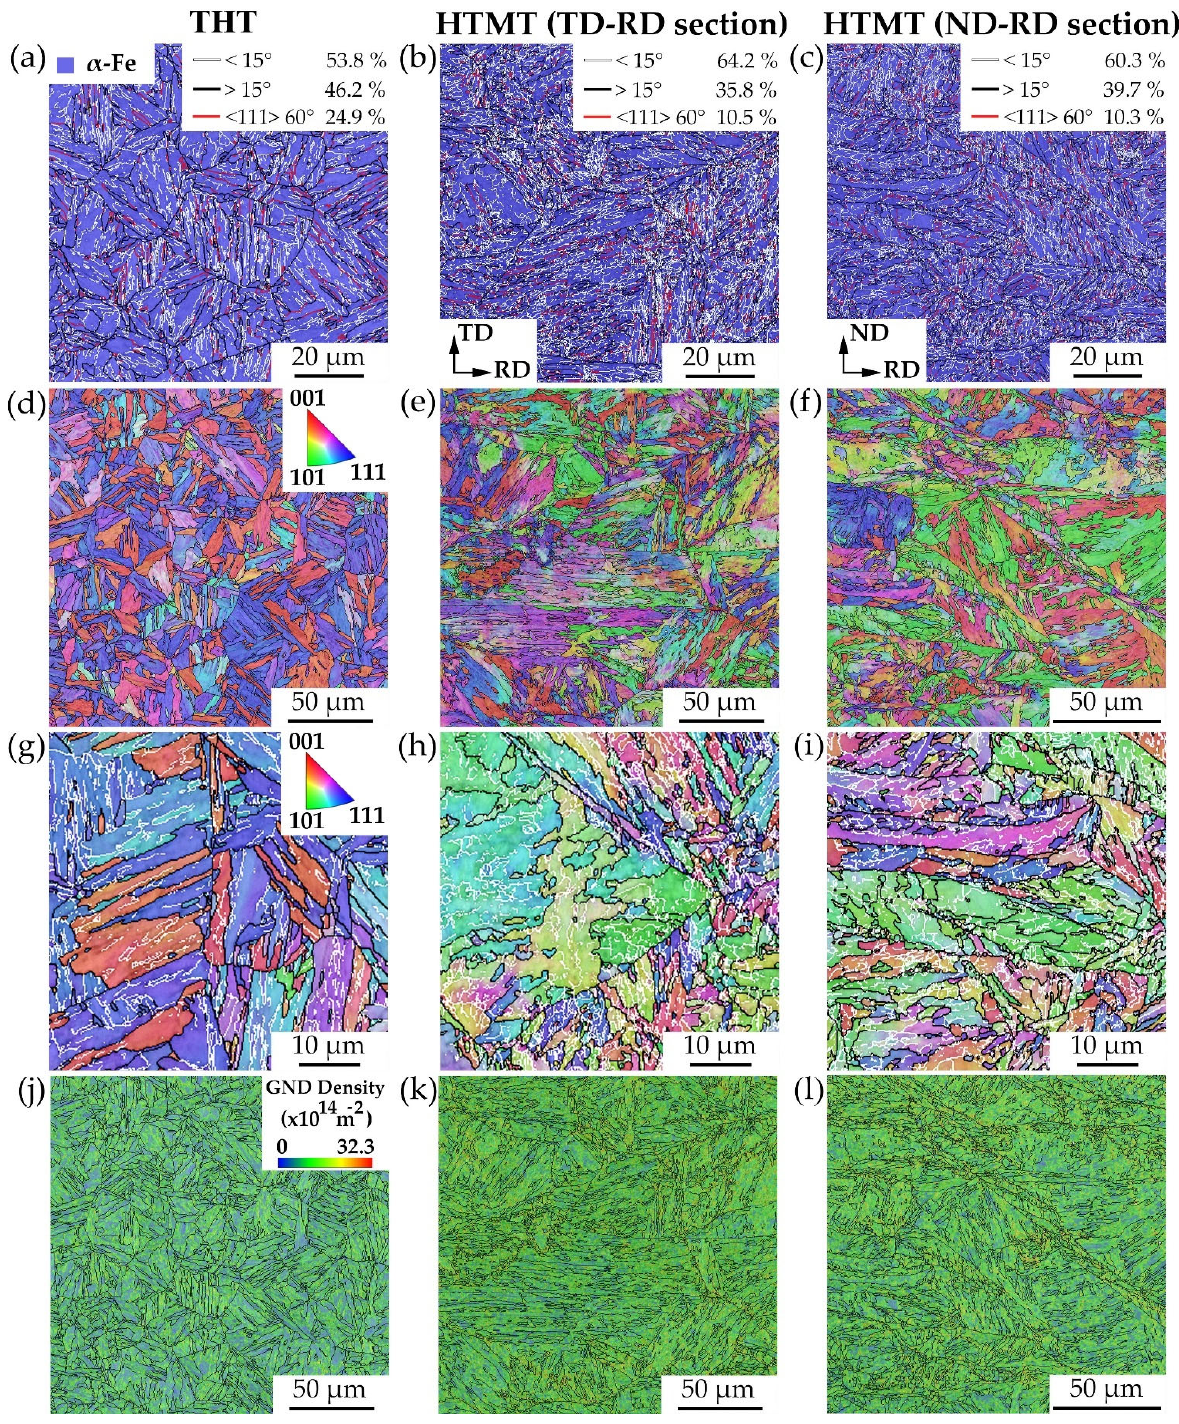
Figure 6. SEM EBSD images of steel microstructure after THT ( a , d , g , j ), HTMT in the section, parallel to the rolling plane ( b , e , h , k ), and in the cross section ( c , f , i , l ). Phase maps ( a – c ), where BCC-Fe is in blue color. IPF (Inverse Pole Figures) orientation maps ( d–i ), corresponding GND (Geometrically Necessary Dislocations) maps ( j – l ). High ‐ , low ‐ angle, and twin boundaries denoted by black, white and red lines, respectively.